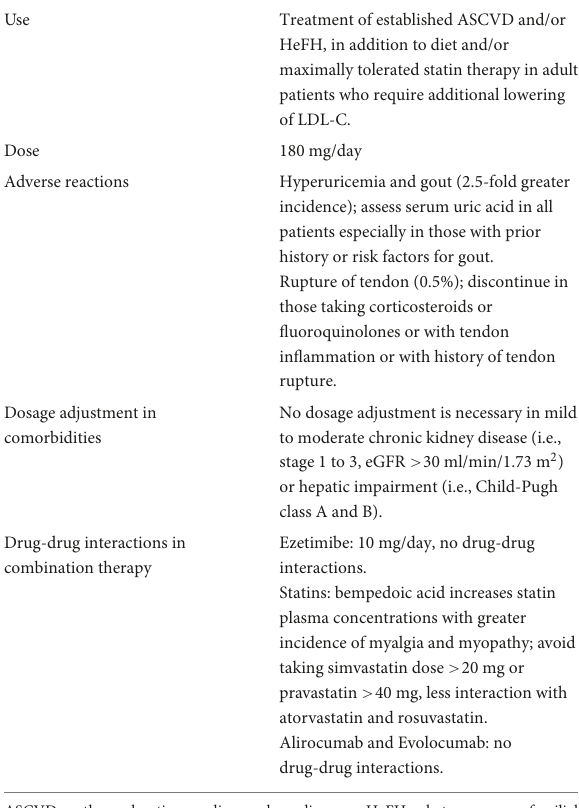
TABLE 3 Practical management of patients receiving bempedoic